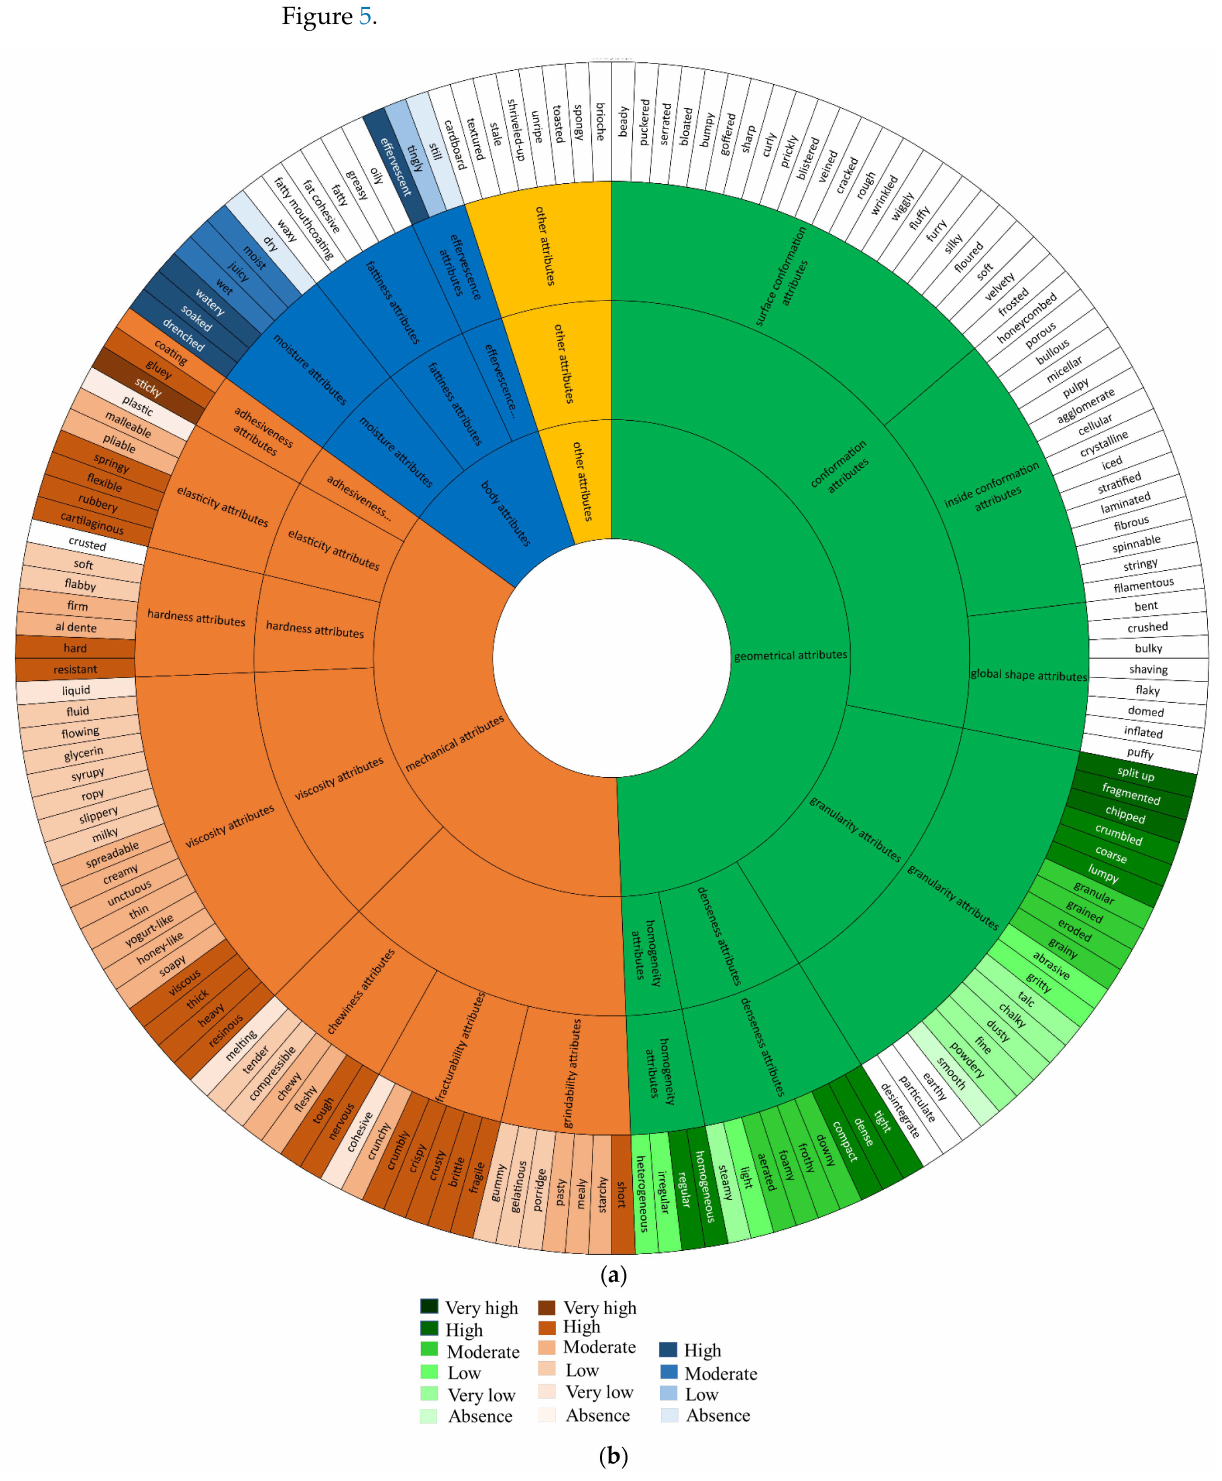
Figure 5. ( a ) Wheel of texture concepts and ( b )